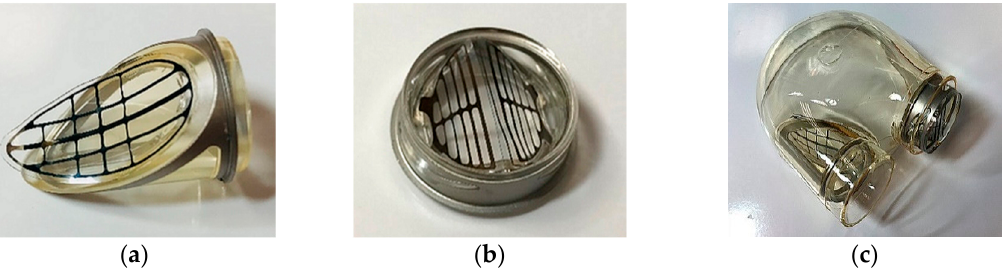
Figure 11. Assembled ( a ) inflow and ( b ) outflow valves, ( c ) blood chamber of the ReligaHeart EXT ventricular assist device (VAD).